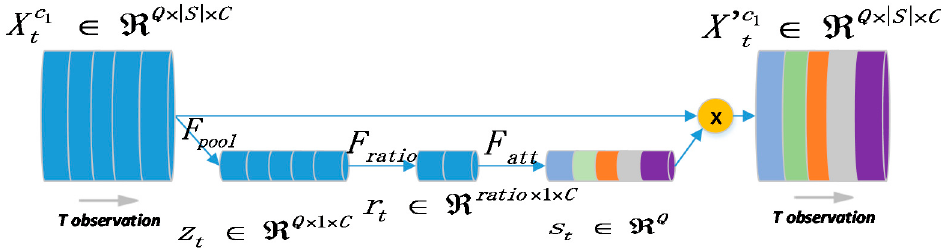
Figure 3. The rectified block as the attention mechanism to provide the fine-grained weights for the original observations in each channel.